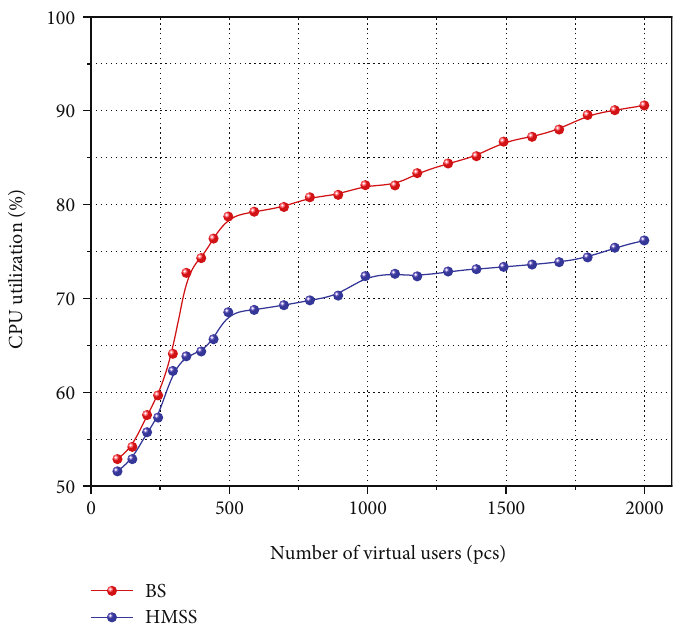
Figure 3: Comparison of CPU utilization between HMSS and benchmark authentication